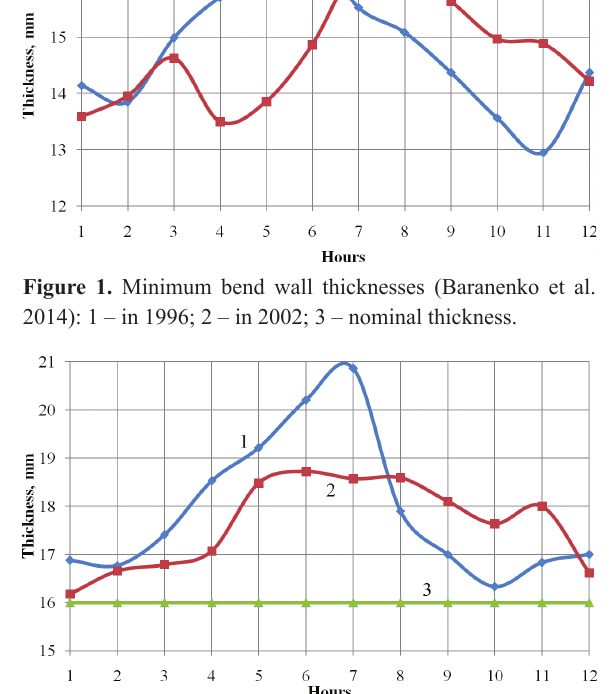
Figure 2. Maximum bend wall thicknesses (Baranenko et al.